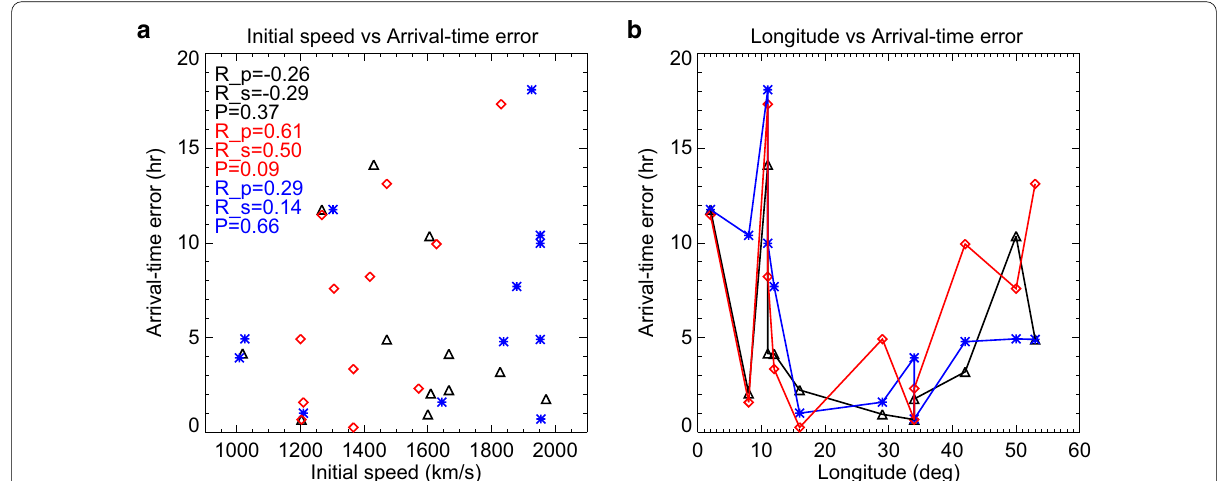
Fig. 4 Initial speed and longitudinal dependence of the arrival-time error. a Relationship between predicted arrival-time error and initial speed of the CMEs. Pearson’s CC (R p ), Spearman’s rank CC (R s ), and the P-value (P) are shown in the left top. b Relationship between predicted arrival-time error and longitude of CME location. Colors indicate CMEs with initial speeds derived from CACTus (blue), the LASCO catalog (red), and the best fit to IPS data